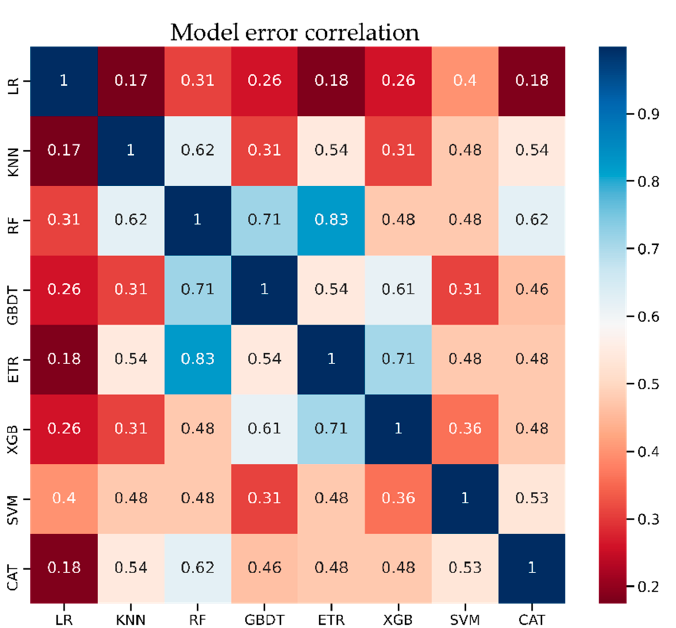
Figure 10. MIC model correlation analysis.